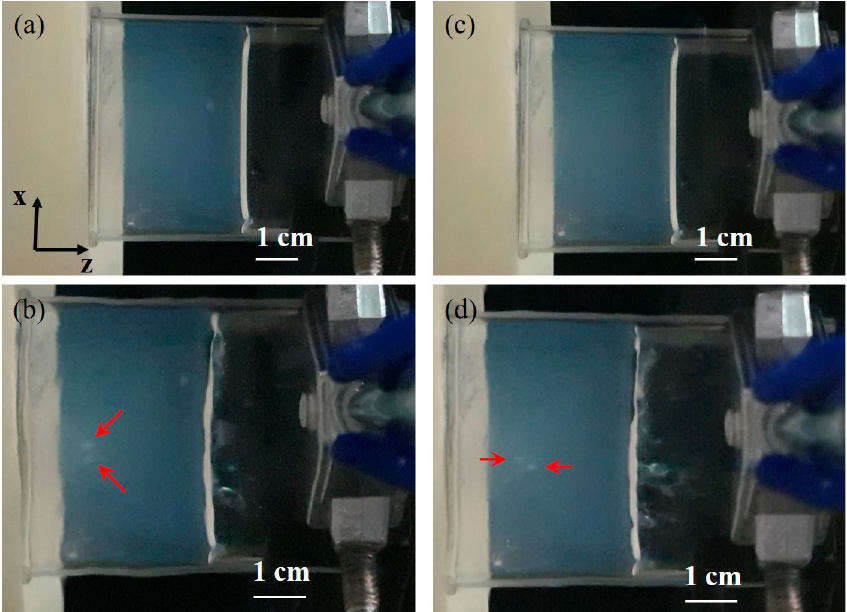
Figure 9. The phantom experiments using the focusing pattern 1 and focusing pattern 2 separately. ( a , b ) show the pictures of the phantom before and after sonication with the focusing pattern 1, respectively. Two white lesions were formed at two foci in the phantom and their location was similar to the simulations. For the focusing pattern 2, ( c , d ) show the phantom before sonication and two up and down white lesions produced by ultrasonic exposure, respectively. All photos were taken in the oblique bird’s-eye view for clear observation. The lesions were pointed out by red arrows.